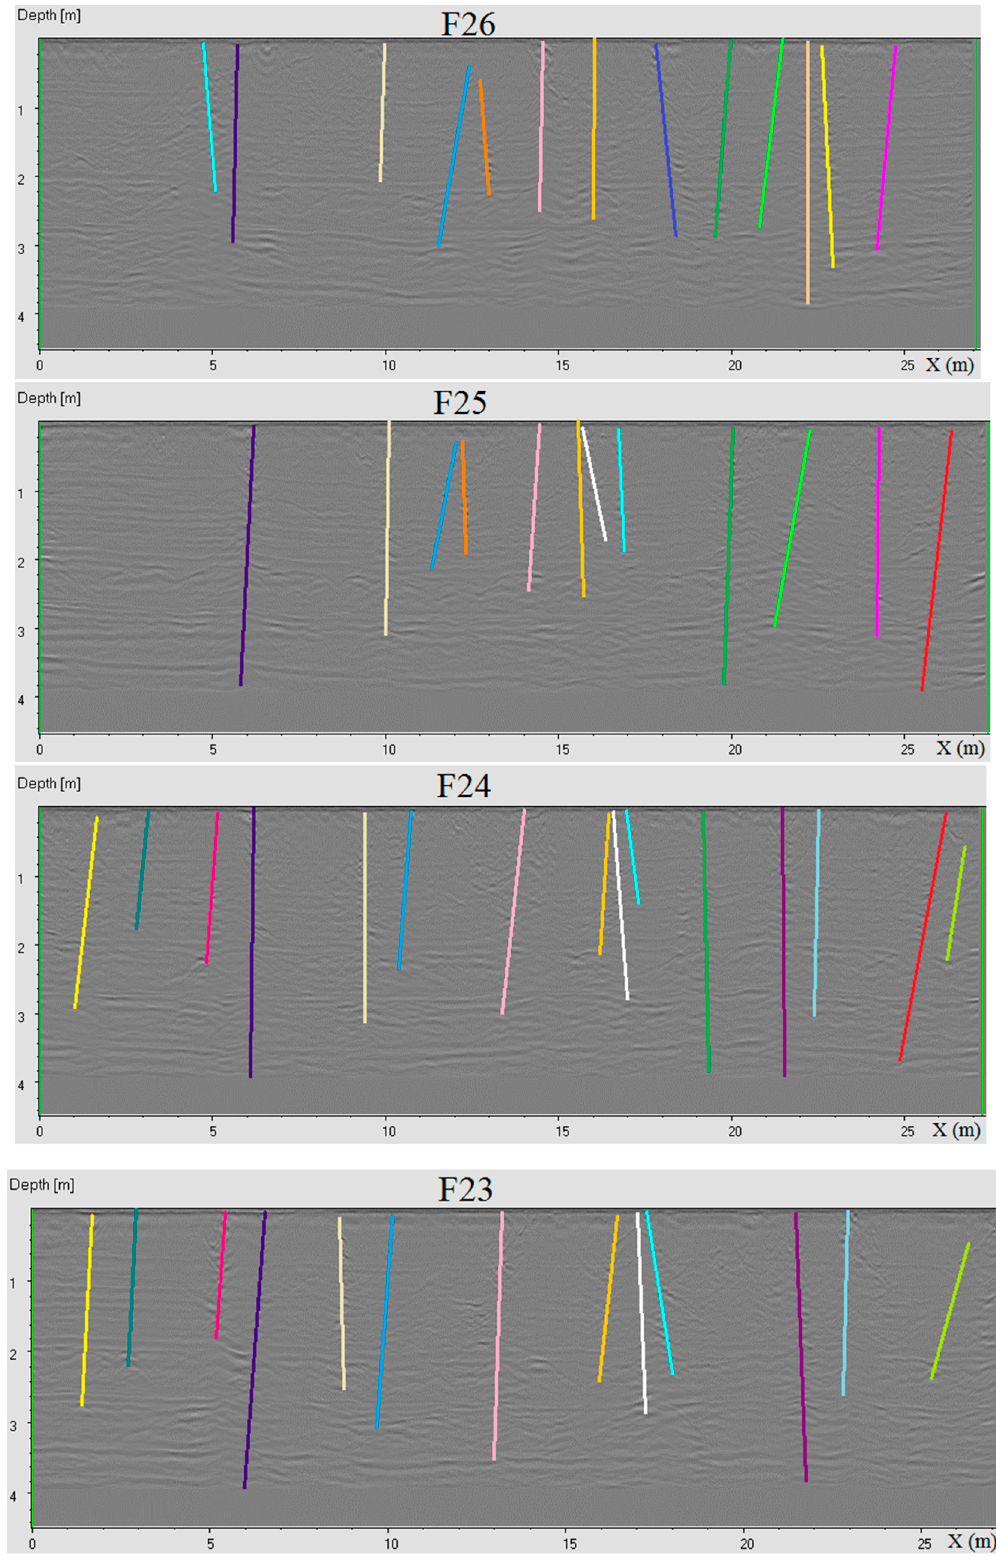
Figure A2. Volume 7: The interpreted radargrams F23, F24, F25, and F26.